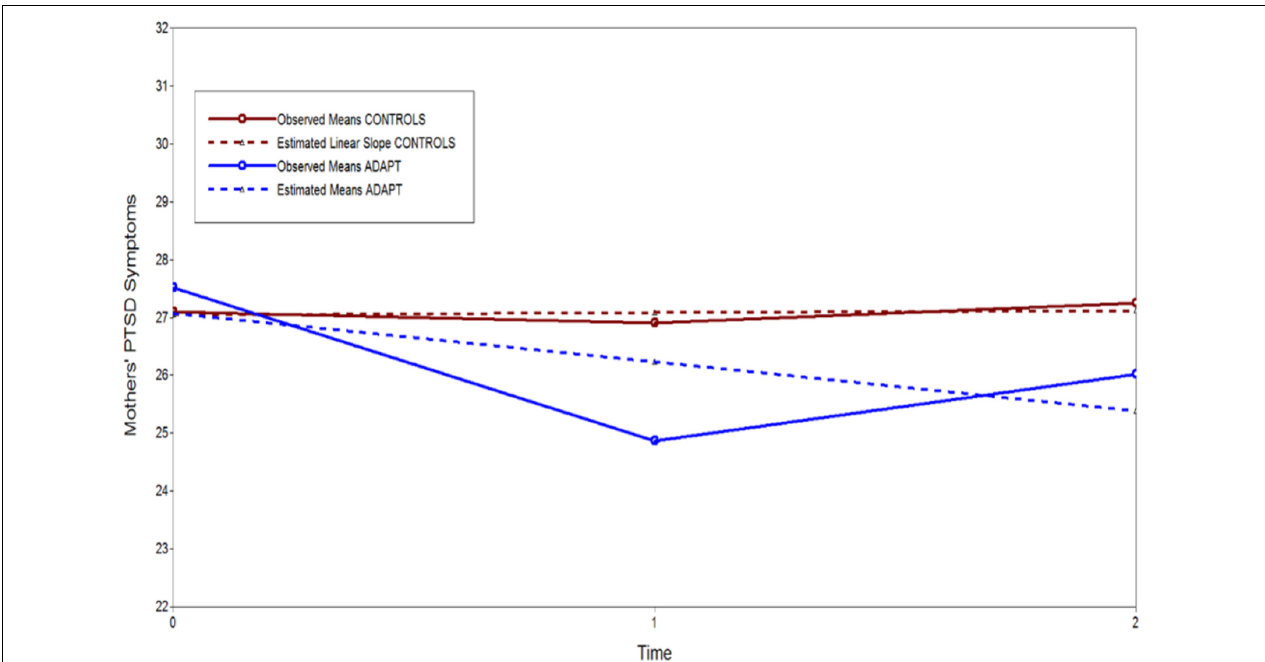
FIGURE 7 | Observed means and unconditional linear growth plot of ADAPT intervention effect on 2-year growth in PTSD for military